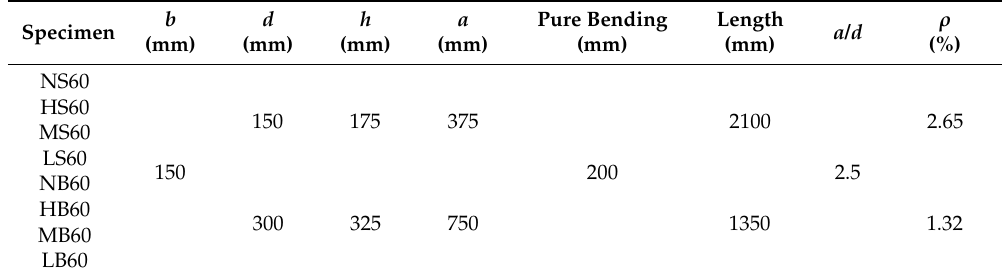
Table 1. Details of the specimen for the shear tests. N: natural aggregate concrete; H: